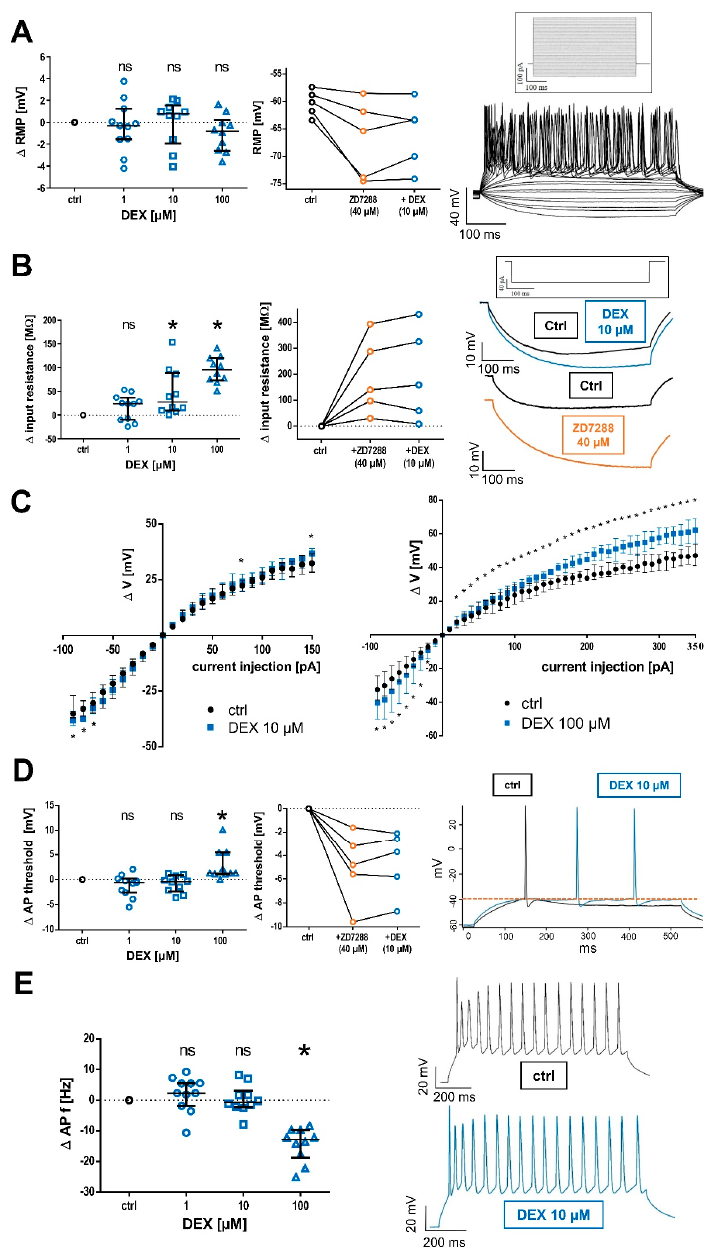
Figure 1. ( A ) DEX did not affect the resting membrane potential (RMP, control: − 58.2 [ − 59.7– − 56.9] mV) over the concentration range from 1 µM to 100 µM after 45 min of exposition, as seen in the left